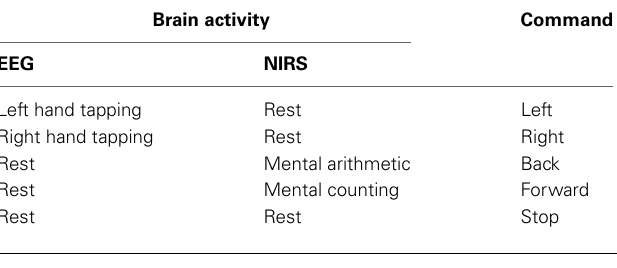
Table 1 | Brain activities of EEG and NIRS for different control commands.